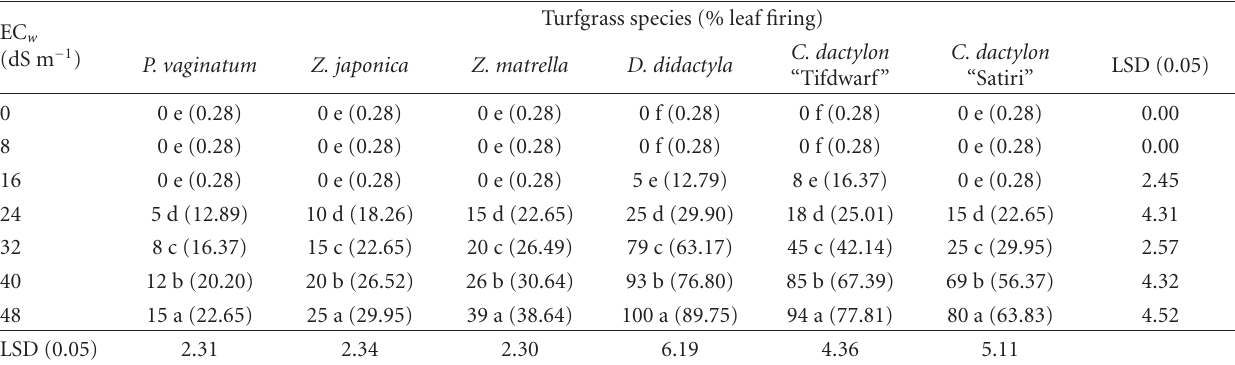
Table 3: E ff ect of salinity on leaf firing of six turfgrass species.